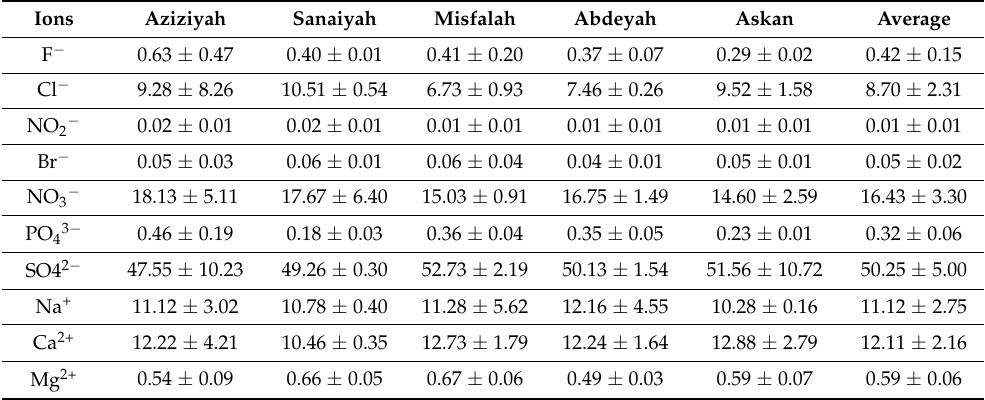
Table 2. Percent contribution of each ion to the total ion mass at different monitoring sites.